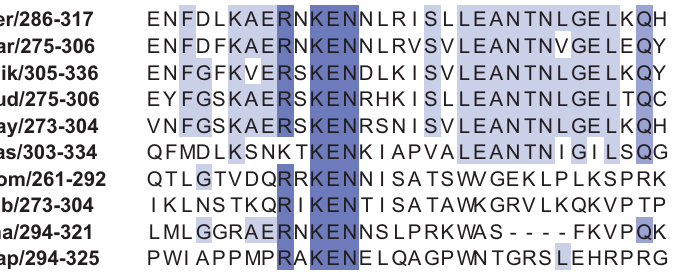
Figure 1. Mad3p contains two conserved KEN boxes. A) Mad3/BubR1 domain structure–schematic diagrams of the Mad3 and Bub proteins indicate the organisation of their functional domains. B) Clustal 6 alignment of the two conserved KEN boxes found in Mad3/BubR1. Species indicated are Saccharomyces cerevisiae (Scer), Saccharomyces paradoxus (Spar), Saccharomyces mikatae (Smik), Saccharomyces kudriavzevii (Skud), Saccharomyces bayanus (Sbay), Saccharomyces castellii (Scas), Schizosaccharomyces pombe (Spom), Candida albicans (Calb), Arabidopsis thaliana (Atha), Drosophila melanogaster (Dmel) and Homo sapiens (Hsap). Numbers indicate residue position within protein sequence.